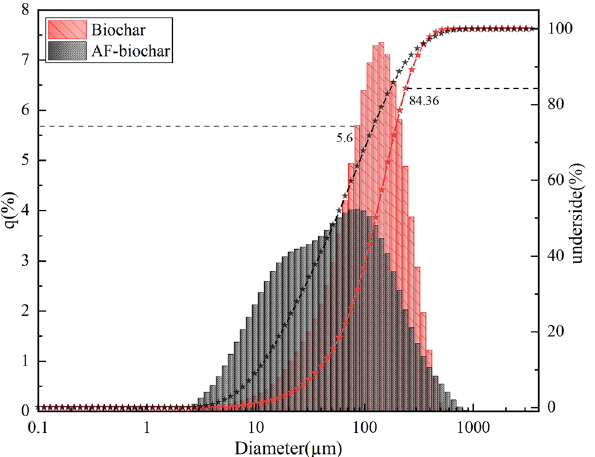
Figure 2: Magnetic hysteresis cycles of AF - biochar ( inset plots show the magnetic - separation AF - biochar after DAP adsorption )